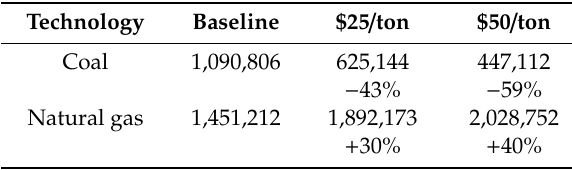
Table 4. Annual U.S. electricity production from coal and natural gas (GWh) for the three scenarios. Percentages are relative deviations from the baseline scenario.